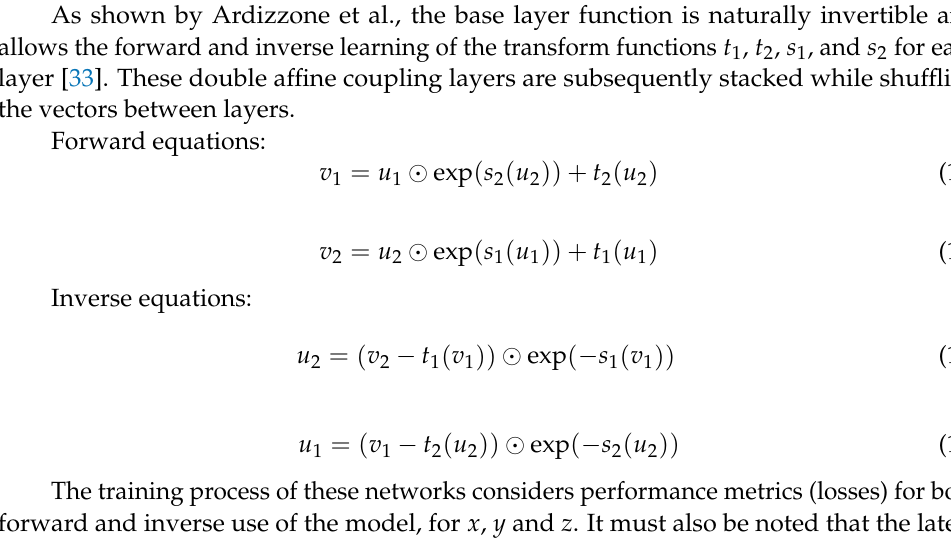
Figure 2. General architecture of the invertible neural network used for process parameter predic- tion.